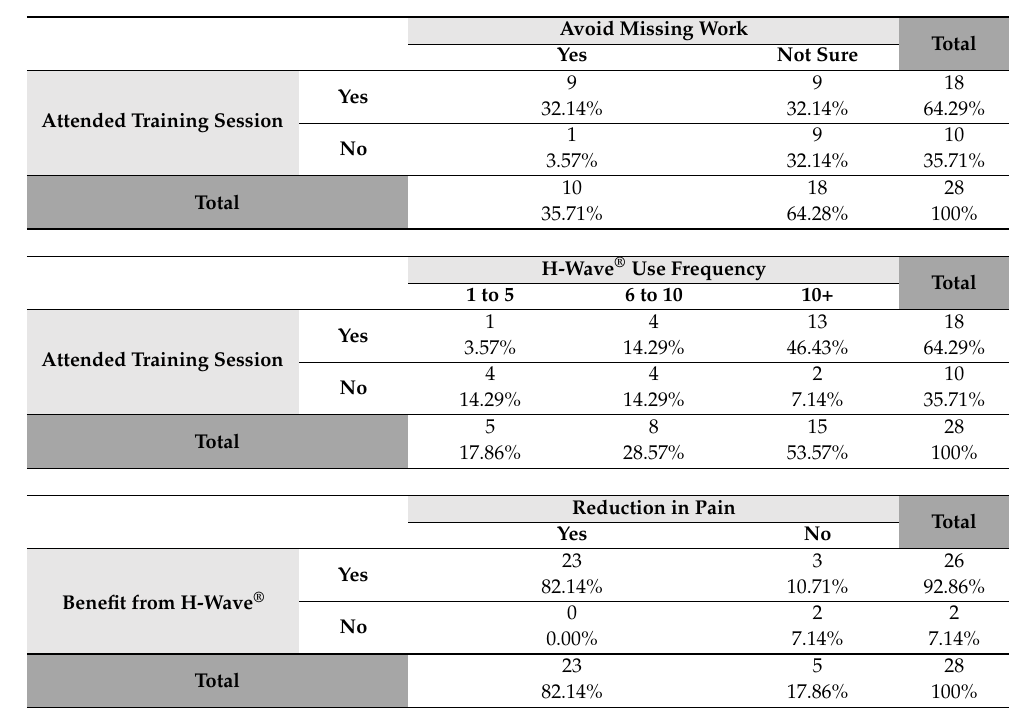
Table 2. Bivariate contingency analysis of survey